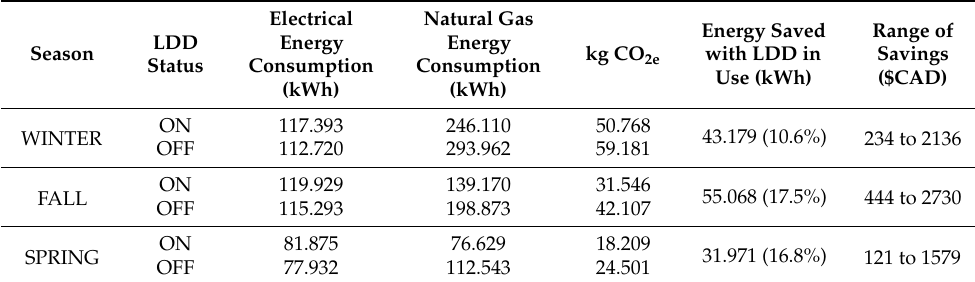
Table 9. Summary of LDD